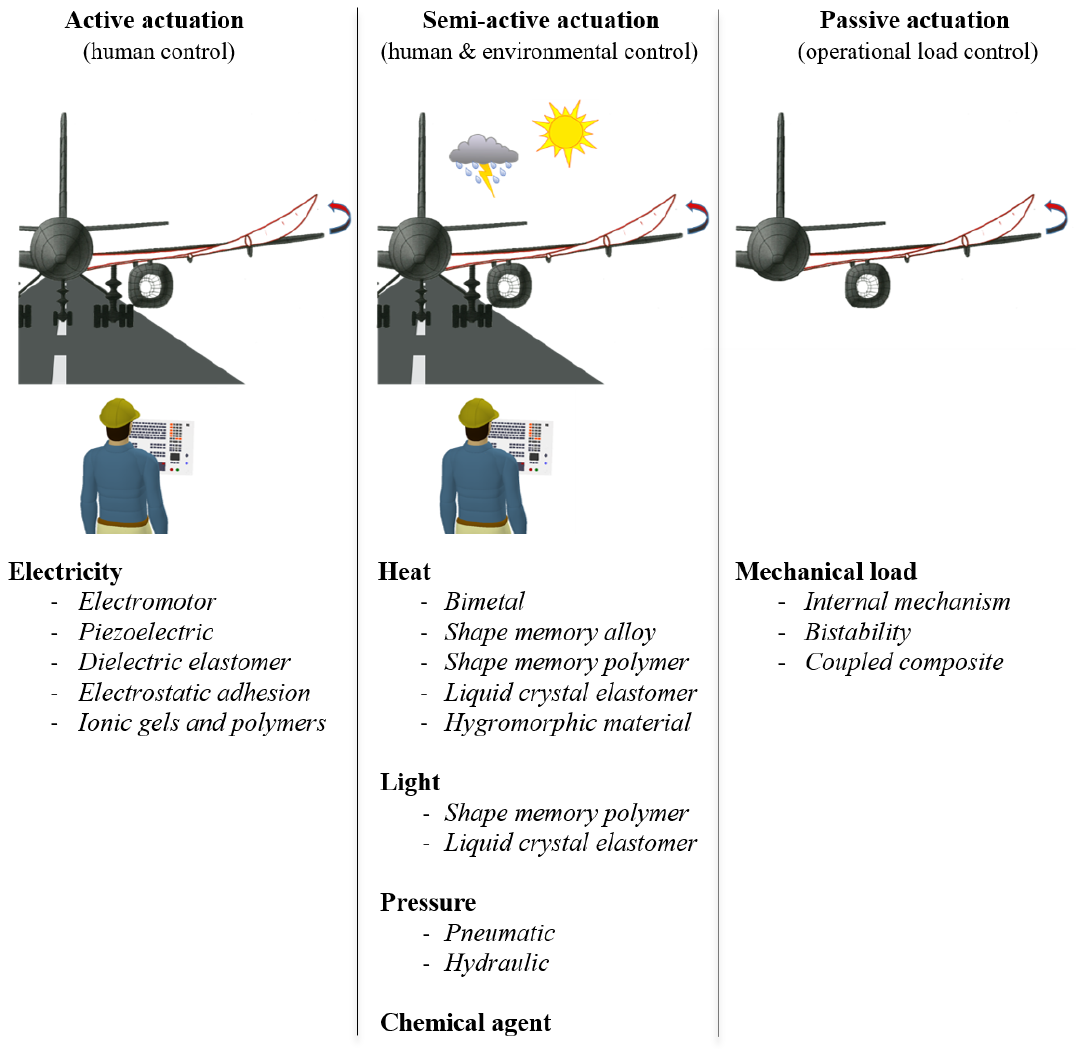
Figure 9. Schematic abstract of approaches to achieve non-conventional shape changes with.